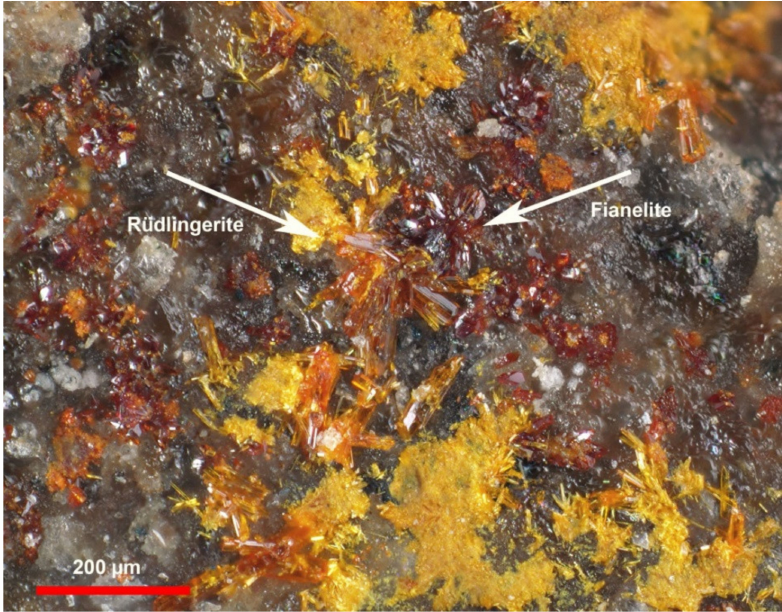
Figure 2. Yellow to orange platy crystals of rüdlingerite (0.1 mm long) with dark orange to red fianelite crystals from Valletta (R. Bracco